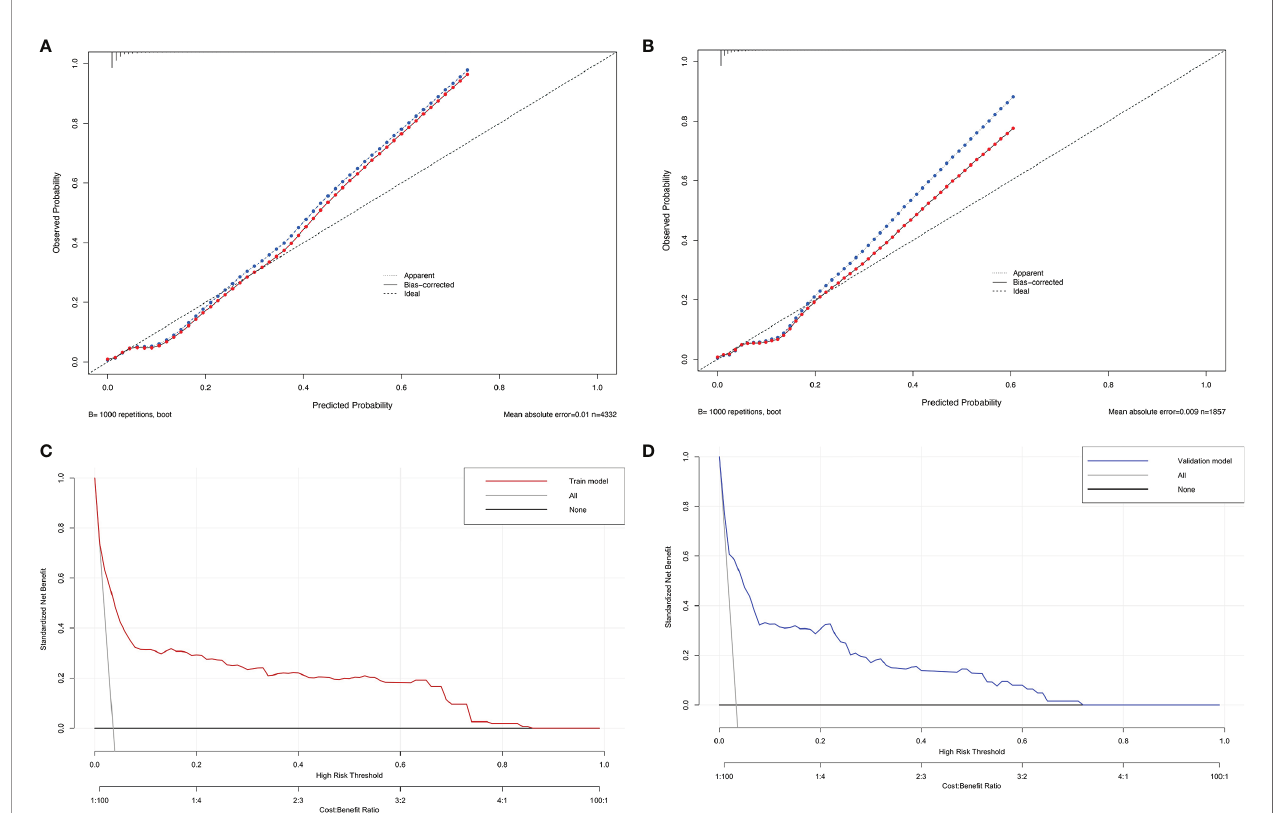
FIGURE 4 | The calibration plot of the nomogram in the training (A) and validation cohorts (B) . Actual rate of SARS-CoV-2 breakthrough infection is shown on the y-axis, and the nomogram-predicted probability of SARS-CoV-2 breakthrough infection is shown on the x-axis. Decision curve compared the net clinical bene fi ts of three scenarios in predicting the SARS-CoV-2 breakthrough infection probability: a perfect prediction model (gray line), no screen (horizontal solid black line), and screen based on the nomogram (red or blue line) in training cohort (C) and validation cohort (D)